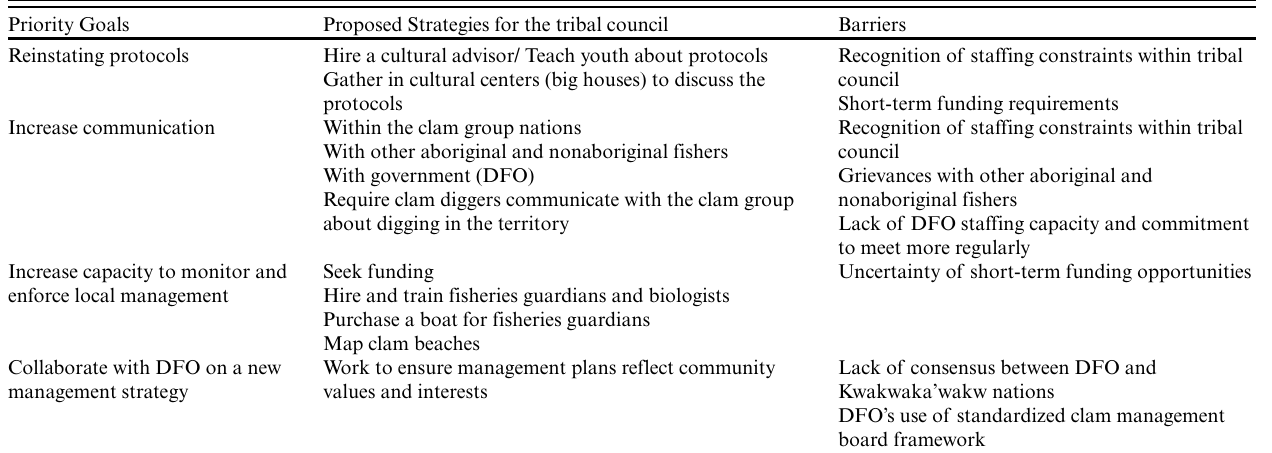
Table 6 . Priority goals, strategies, and barriers in implementing local clam management strategies as identified by Broughton clam group members. DFO = Canadian Department of Fisheries and